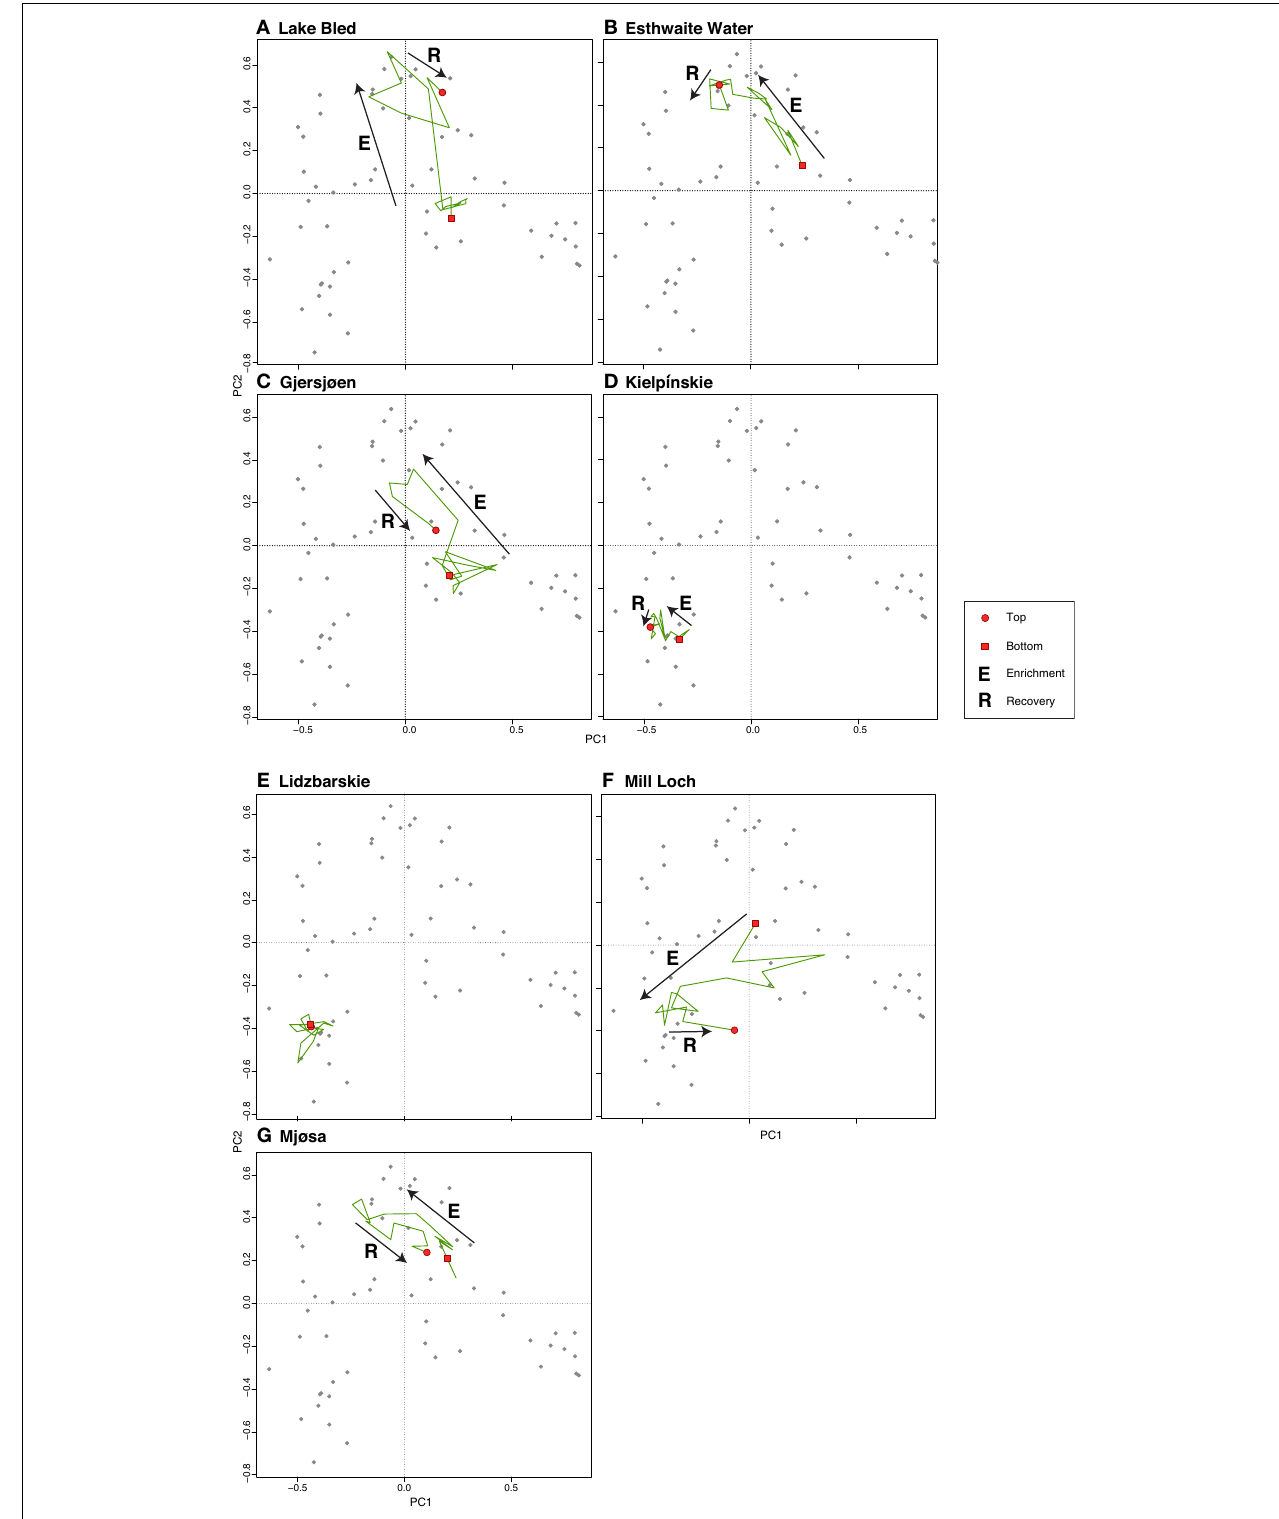
FIGURE 6 | Deep lake cores plotted passively on a PCA of training set samples. The direction of change over time is shown by the arrows. (A) Lake Bled, (B) Esthwaite Water, (C) Gjersjøen, (D) Kielpinskie, (E) Lidzbarskie, (F) Mill Loch, (G) Mjøsa.